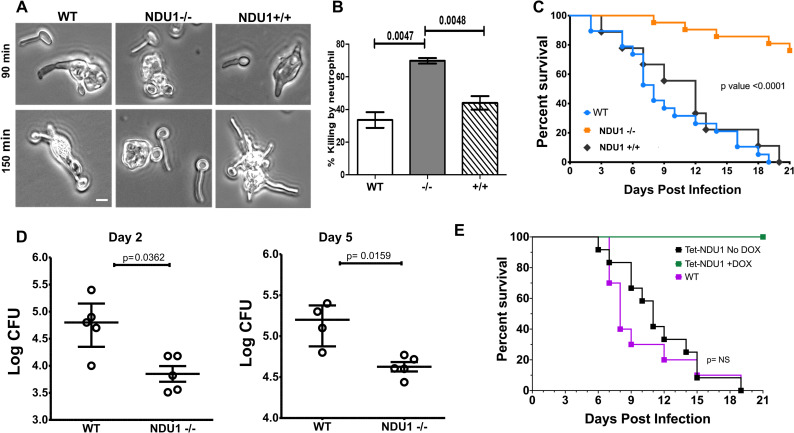
Susceptibility to neutrophils and defective virulence of NDU1 mutant.(Note: orf19.2500 is referred as NDU1 from this figure on). Yeast C. albicans WT, NDU1−/−, and NDU1+/+ cells grown overnight were incubated along with primary human neutrophils (3:1 MOI), for 3 hours, and the extent of phagocytosis was visualized by confocal microscopy at 90 min and 150 min (A). The extent of yeast cell killing by neutrophils was quantified by CFU measurement at 3 h. Scale bar = 5 μM (A). Data are mean + SEM from 3 biological replicates. CD1 outbred mice were infected via tail vein with 2.5 × 105 cells of WT, NDU1−/−, and NDU1+/+ (10 mice each × 2 replicates), and the impact of disseminated candidiasis on the overall survival of mice was monitored for 21 days. *p < 0.0001 mutant vs. WT and revertant, log-rank test (B). Mice were sacrificed on day +2 and +5 relative to infection, and their kidneys processed for tissue fungal burden, determined by plating on solid media. Data are median ± interquartile range. *p < 0.05 mutant versus WT, Wilcoxon rank-sum test (C). Survival curves for the different groups of mice (10 animals per group) infected with the C. albicans WT isogenic parental strain or with the C. albicans tetO-NDU1/ndu1 strain in the presence or absence of DOX. Statistically significant differences were measured between the comparison groups of mice (D). Survival curves for the different groups of mice (10 animals per group) infected with the C. albicans NDU1/NDU1 isogenic parental strain (WT) or with the C. albicans tetO-NDU1/ndu1 (Tet-NDU1) strain in both the presence and the absence of DOX. DOX was added in the water 24 h after C. albicans infection. Statistically significant differences were observed between the comparison groups of mice Tet-NDU1+DOX versus WT or Tet-NDU1 No DOX (p < 0.001). Survival between the latter 2 groups was not significantly different (NS; p = 0.8). Raw data are found in the file S1 Data. CFU, colony-forming unit; DOX, doxycycline; WT, wild type.